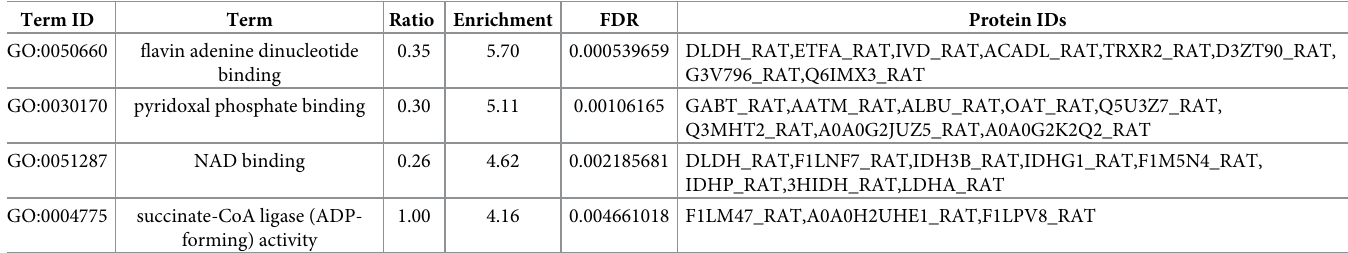
Table 4. The significantly enriched GO terms related to molecular